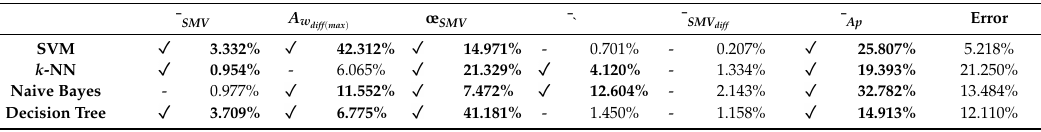
Table 7. Error reported by the ANOVA analysis and relative influence of the election of the six considered input features on the global result for the four learning machine strategies. The symbol ( ) or (-) indicates if the corresponding feature is included (or not) in the combination that achieves the (statistically significant) best